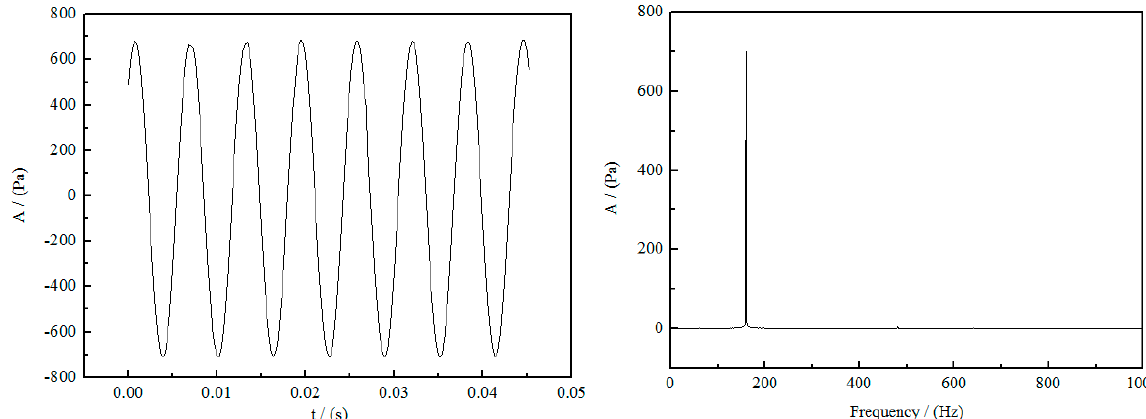
Figure 2. Acoustic pressure signal. ( Left ) the acoustic pressure signal measured by a single microphone, ( right ) the acoustic frequency obtained by Fourier transform of the acoustic pressure signal.